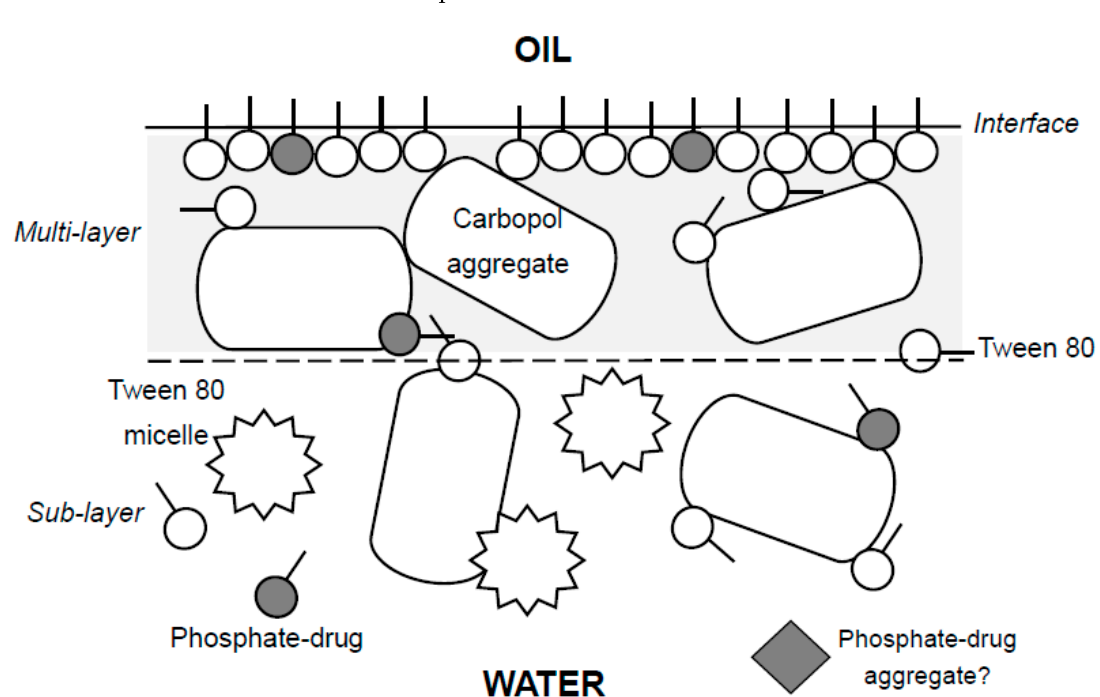
Figure 12. Phenomenological cartoon showing the representation of the various ‘elements’ making up the interfacial adsorbed layer associated with Tween 80, betamethasone 21-phosphate (BMP) and carbopol based oil-in-water emulsions. Key elements are the hydrogen bonded associate carbopol-Tween interfacial adsorbate, free carbopol and free Tween 80 along with micelles of Tween 80. The BMP drug may also associate into aggregates but this is surmised from the surface tension plot (Figure 5). Other associations may include apolar interaction between the alkyl tails of the primary surfactant, with each other and also with the BMP.